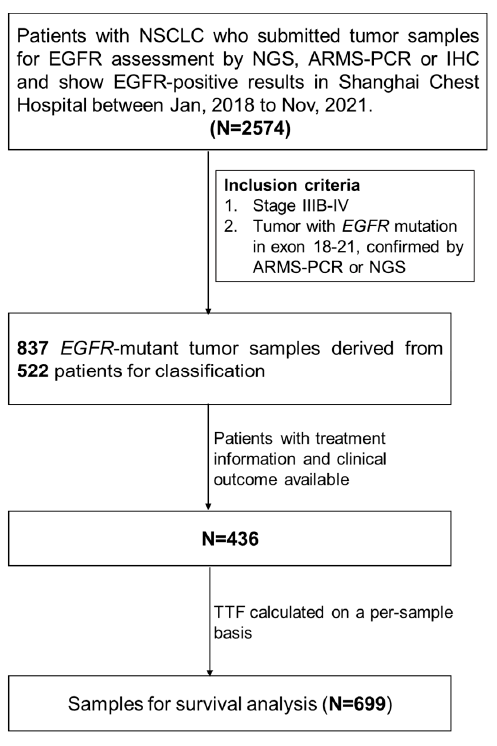
Figure 1. Flowchart of the study design.